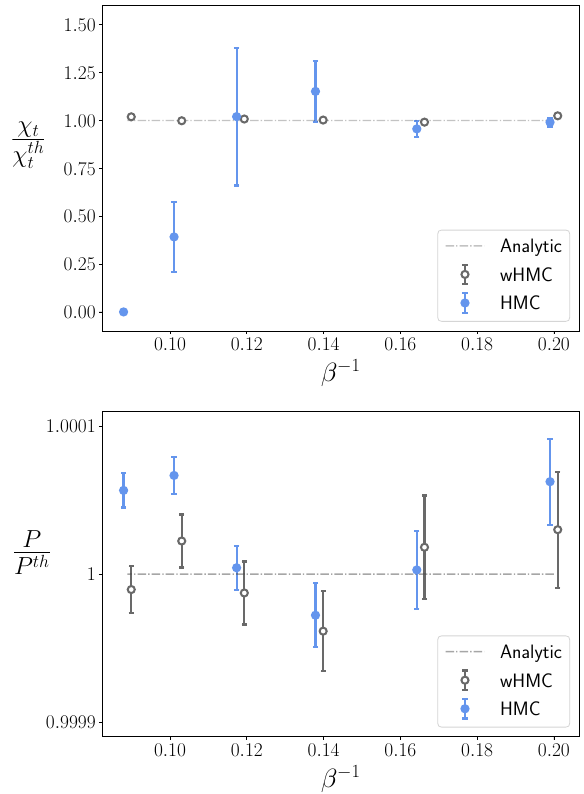
Fig. 6 Average topological susceptibility (top) and plaquette (bottom) normalized to the exact result of Eq. (7) as a function of β − 1 for both algorithms